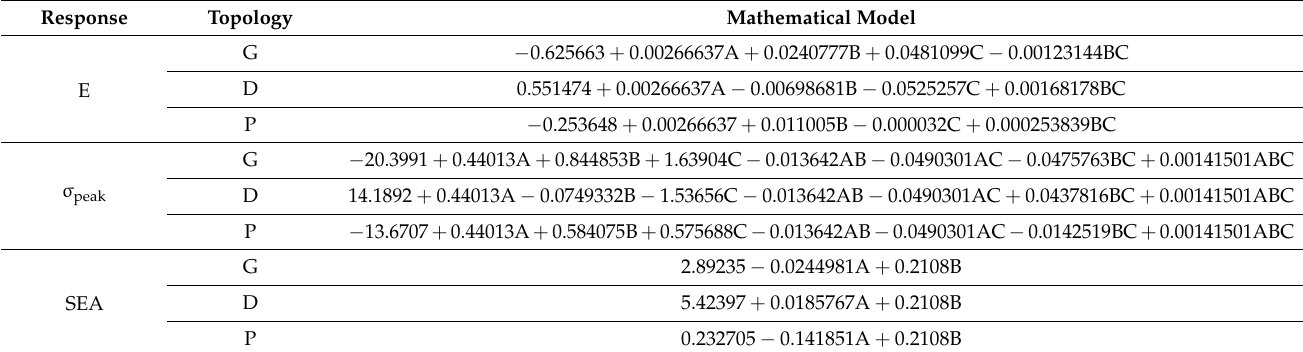
Table 8. Mathematical prediction models of E, σ peak , and SEA.